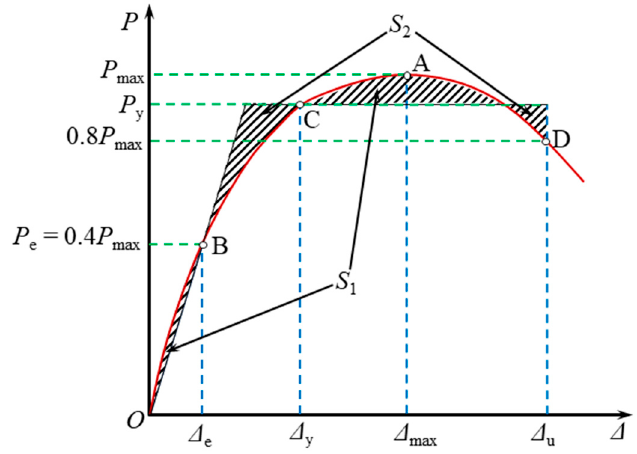
Figure 12. The characteristic values. Table 4. The characteristic values.